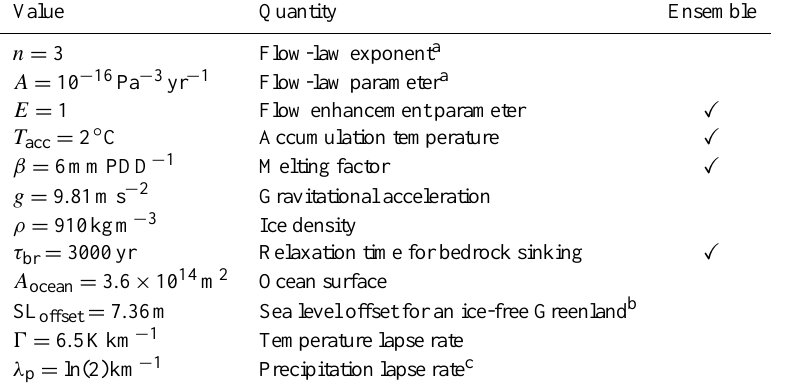
Table 1. Values of constants used in the ice model. The parameters that are used to tune the model are highlighted with a checkmark and therefore not constant between different members in the ensemble (Table 3). The values for the reference parameters set are given here.